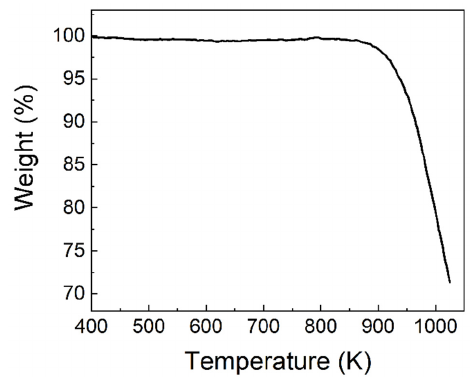
Figure 1. TGA of anti-perovskite [MnBr 4 ]BrCs 3 film.